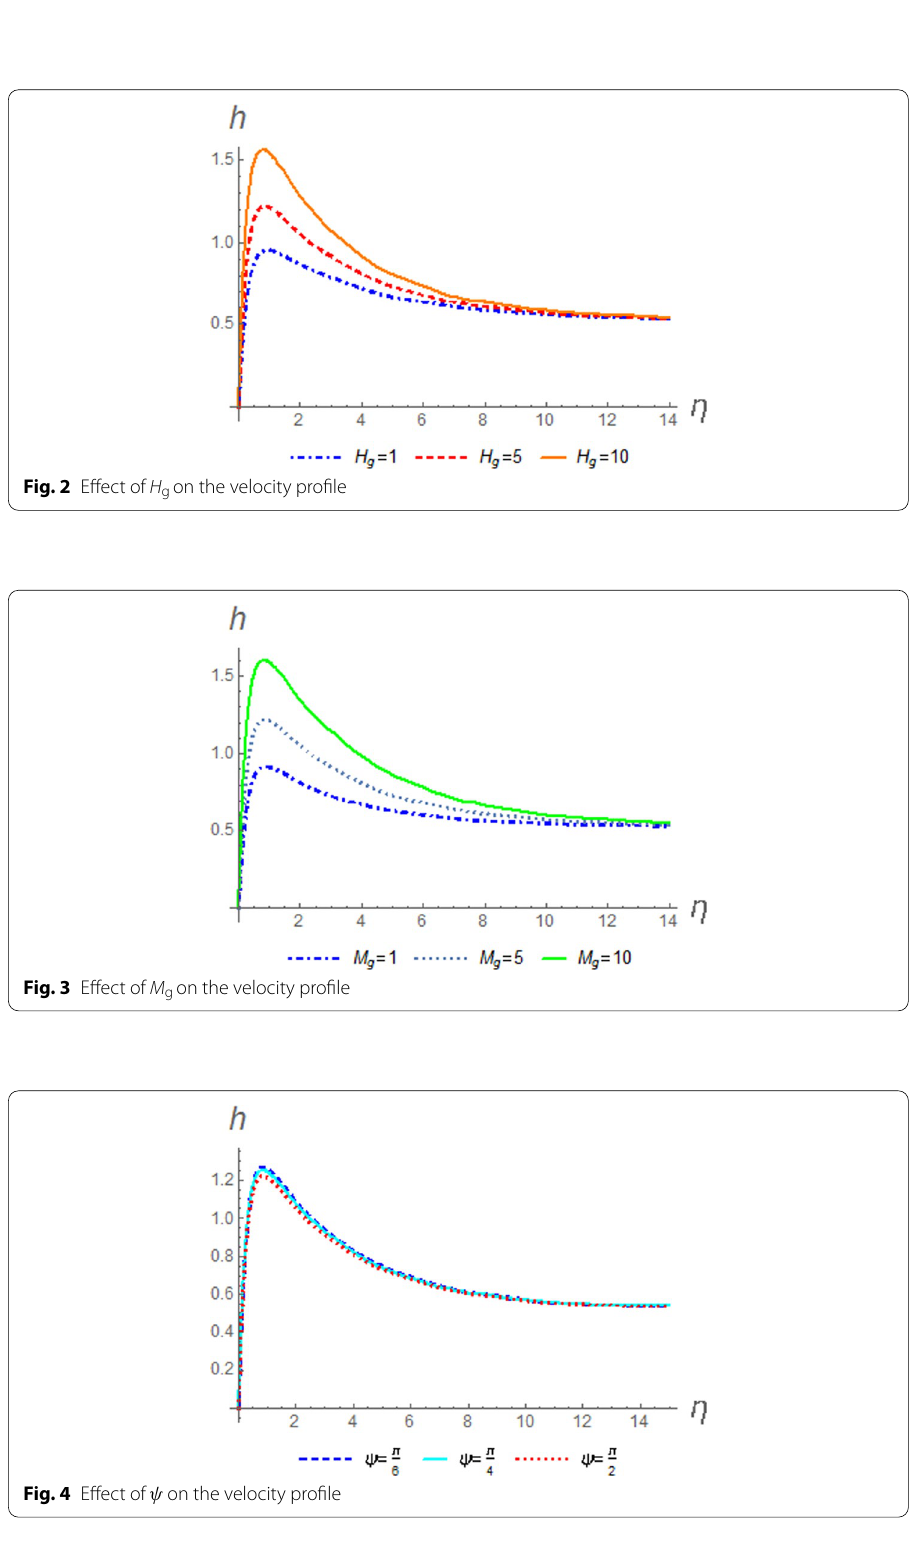
Figure 6 portrays effects of permeability of the porous medium parameter ( K ) on velocity profiles. Momentum boundary layer thickness is boosted with higher values of K . Physically, this result can be justified by ignoring the permeability holes.